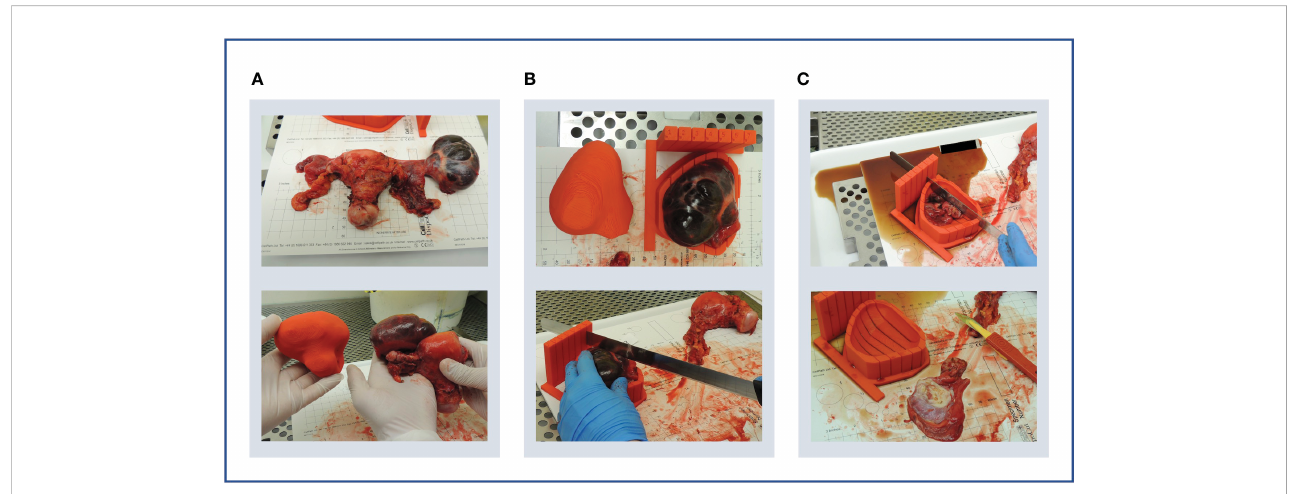
FIGURE 5 Case 1. (A) Upper panel: en bloc resection specimen. Lower panel: en bloc resection specimen with left ovarian tumour next to its 3D-printed tumour replica. (B) Upper panel: left ovarian tumour in its 3D mould, next to its tumour replica. Lower panel: specimen knife placed in slit prior to slicing. The 5 mm slits were too narrow for the knife. (C) Upper panel: the cystic tumour collapsed immediately on capsule rupture as expected, releasing cystic fl uid.Lower panel: Tumour tissue was insuf fi cient for research sampling as expected based on the pre-operative CT